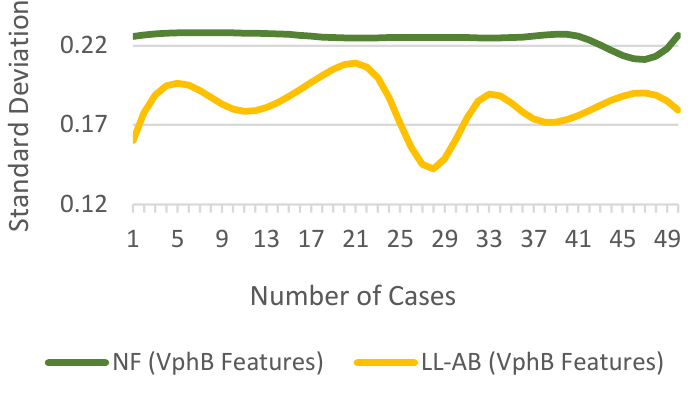
Figure 6. STD of Vph B for NF and fault